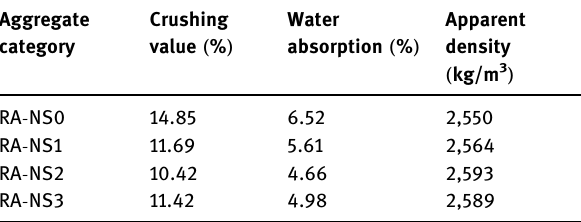
Table 5: E ff ect of NS on physical properties of RA Aggregate category